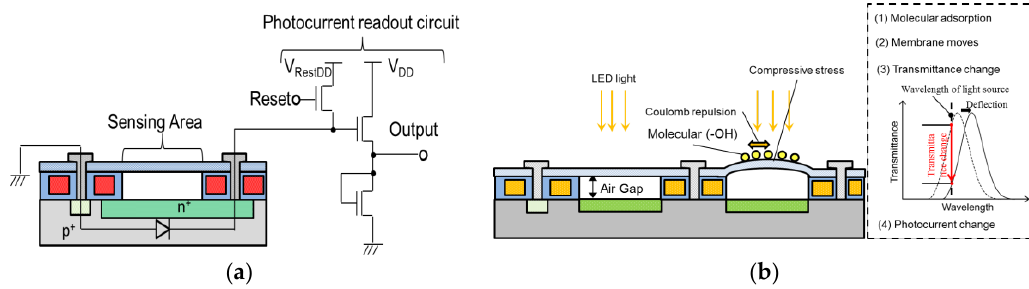
Figure 1. Circuit diagram of the Fabry–Perot sensor with the source follower circuit. ( a ) Schematic view of the microelectromechanical systems (MEMS) Fabry–Perot interferometric surface stress sensor and ( b ) deformation model of the movable film due to Coulomb repulsion.